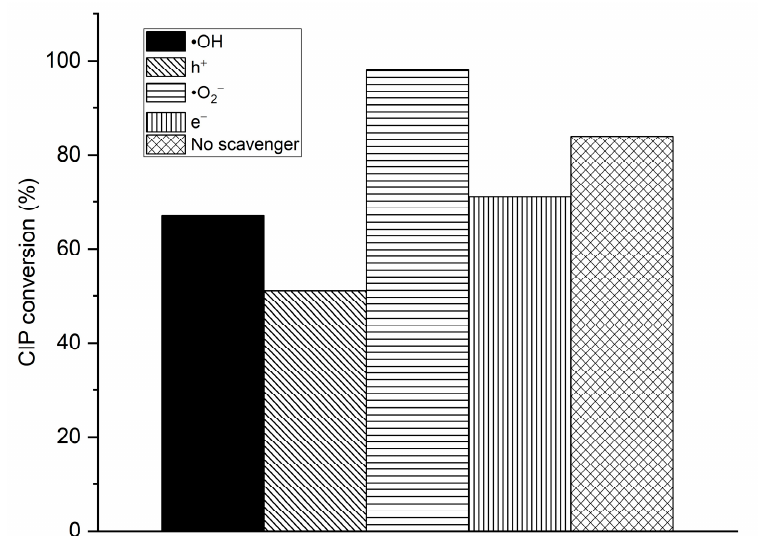
Figure 13. CIP conversion with the involvement of different